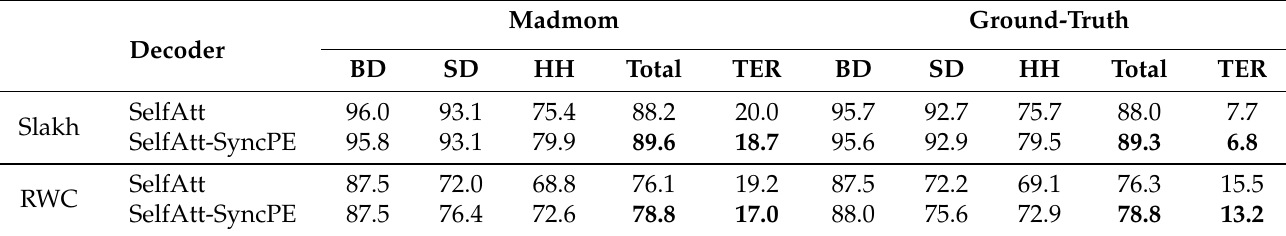
Table 7. F-measures (%) and TERs obtained by CNN-SelfAtt with the conventional positional encodings and CNN-SelfAtt- SyncPE with the proposed tatum-synchronous positional